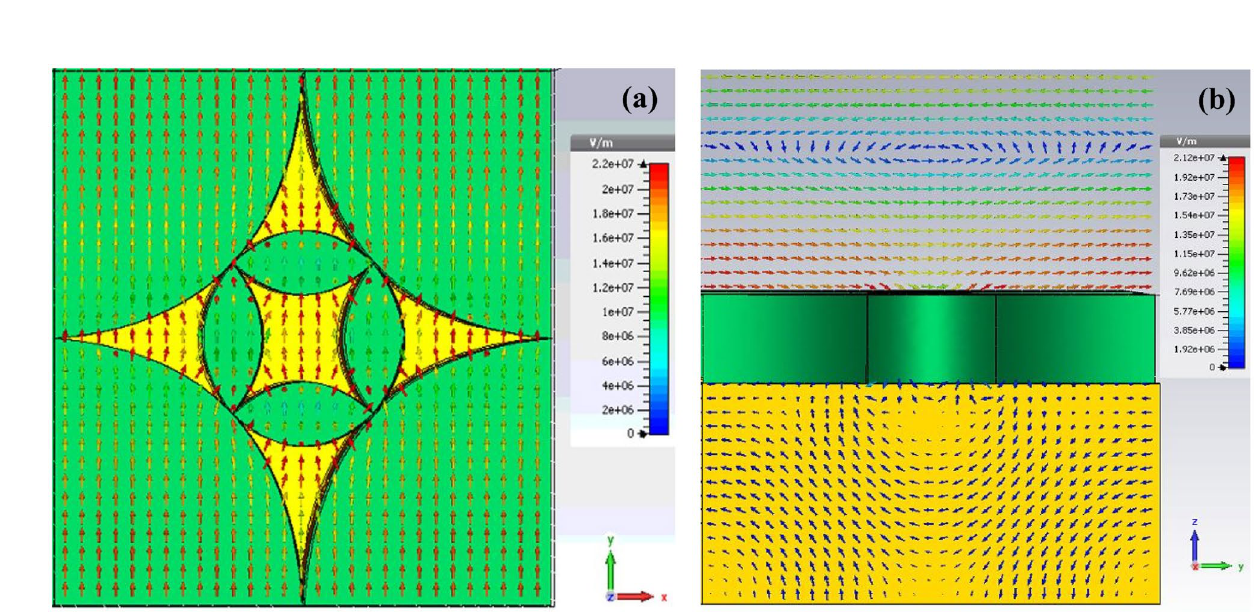
Figure 5. ( a ) Top view ( b ) cross-sectional view (at x = 0.141 µm) of electric field distribution of the proposed unit-cell antenna at 278.5